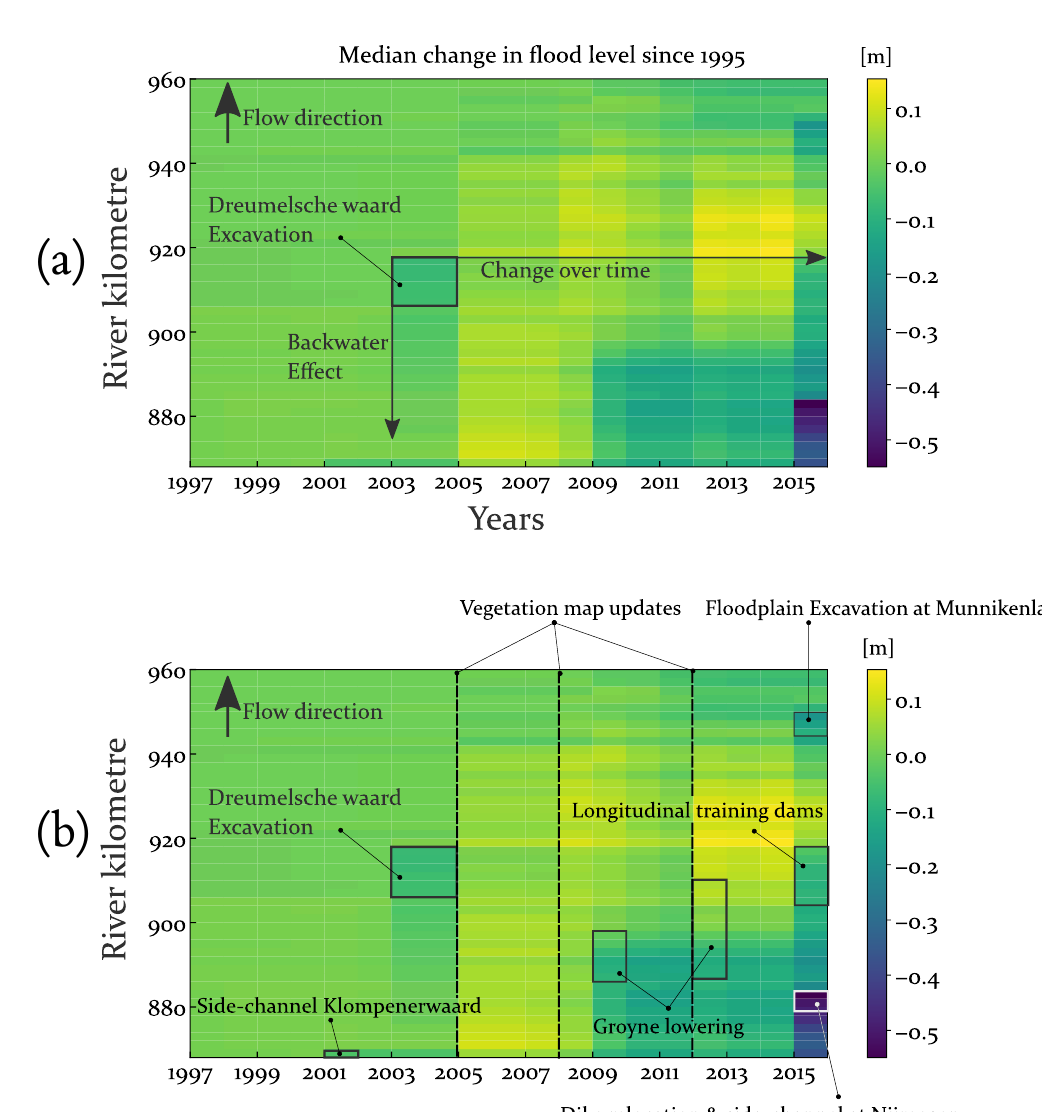
Figure 3. Simulated changes in the water level at a constant 10,165 m 3 s − 1 since 1995. ( a ) Annotation on how an intervention affects the water levels in time and space. ( b ) Annotation of the major changes to the river